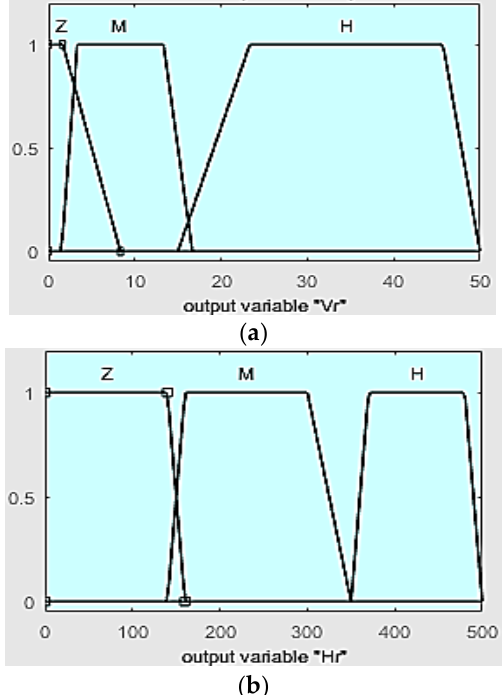
Figure 11. Membership functions of the output variables: ( a ) the ventilation rate Vr ( b ) and the heating rate Hr .